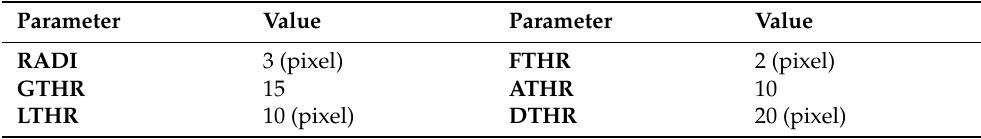
Table 1. The parameters of filter radius ( RADI ), edge gradient threshold ( GTHR ), curve length thresh- old ( LTHR ), line-fitting error threshold ( FTHR ), angular difference threshold ( ATHR ), and linking distance threshold ( DTHR ) implemented in Geomatica software’s LINE module [92] to extract surface